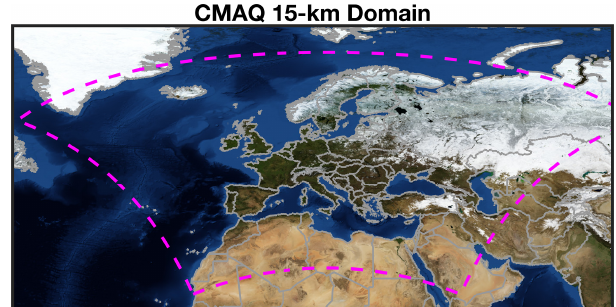
Figure 1. The WRF-CMAQ 15km domain covering Europe. The background picture is based on the publicly available NASA Blue Marble (©